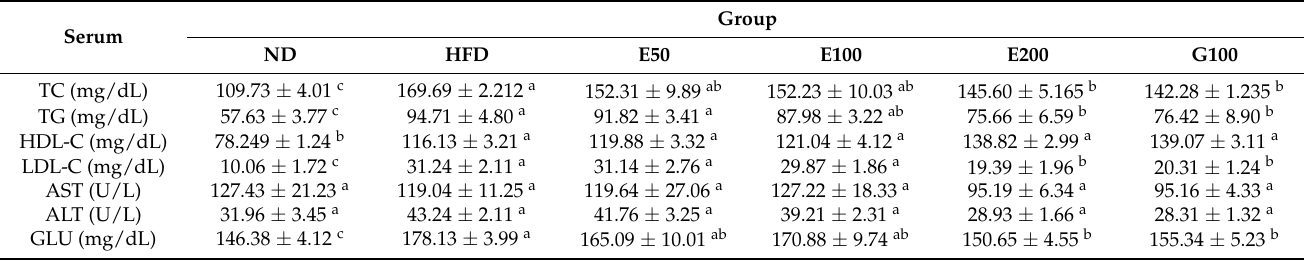
Table 3. Effects of EAW on biochemical serum parameters in HFD-induced obese